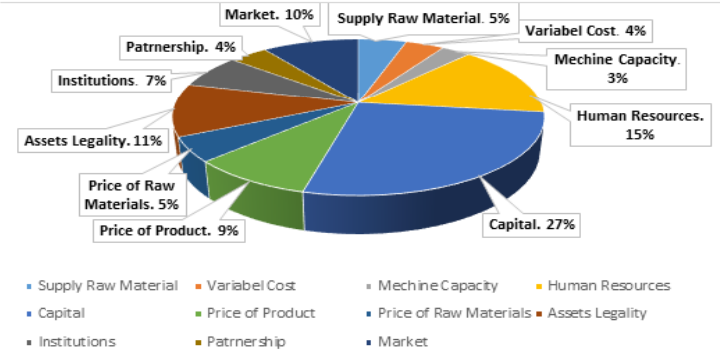
Figure 1: Exploring Problem of Cocoa Oil Small-sized